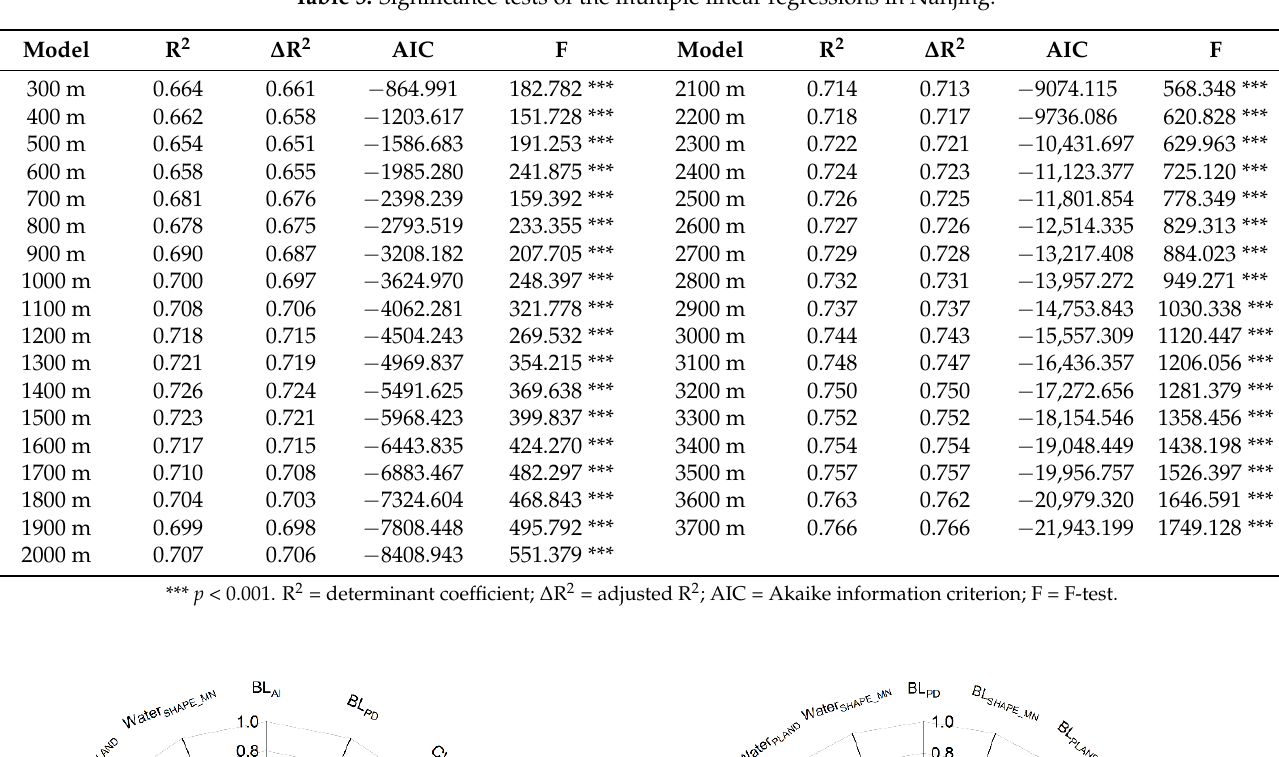
Table 5. Significance tests of the multiple linear regressions in Nanjing.